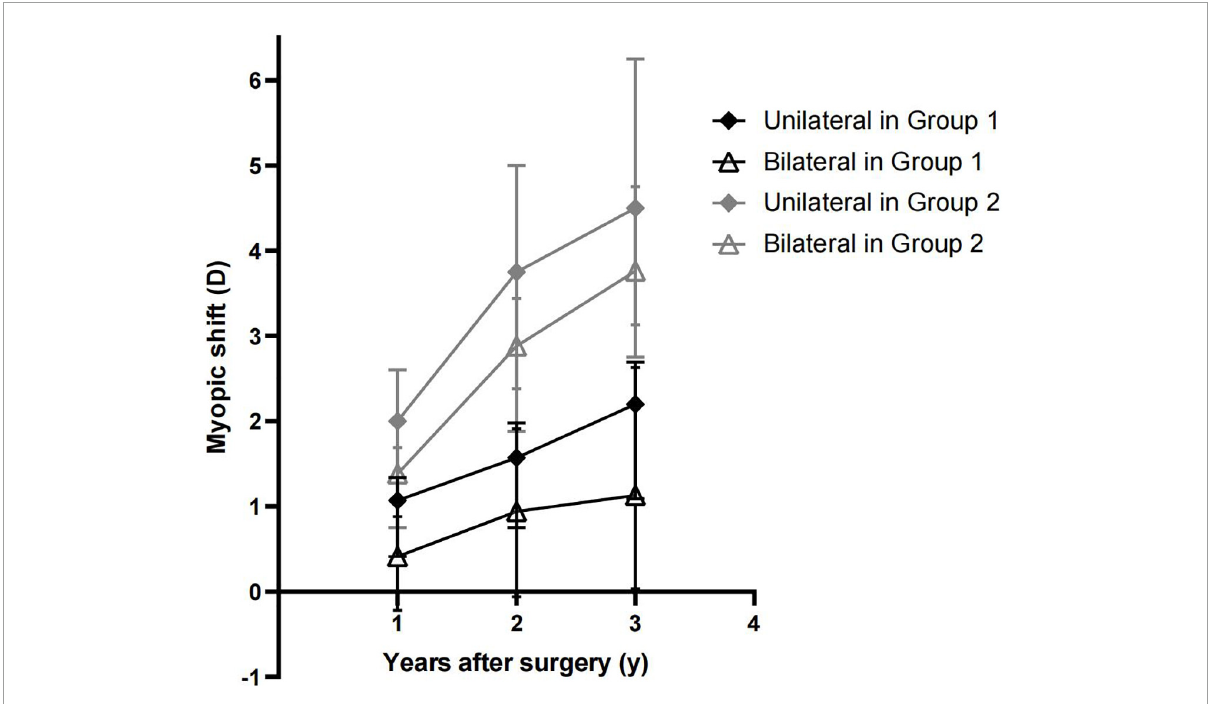
FIGURE2 Comparison of myopic shift (MS) in patients with unilateral and bilateral cataracts in the same pre-operative axial length (AL) group.